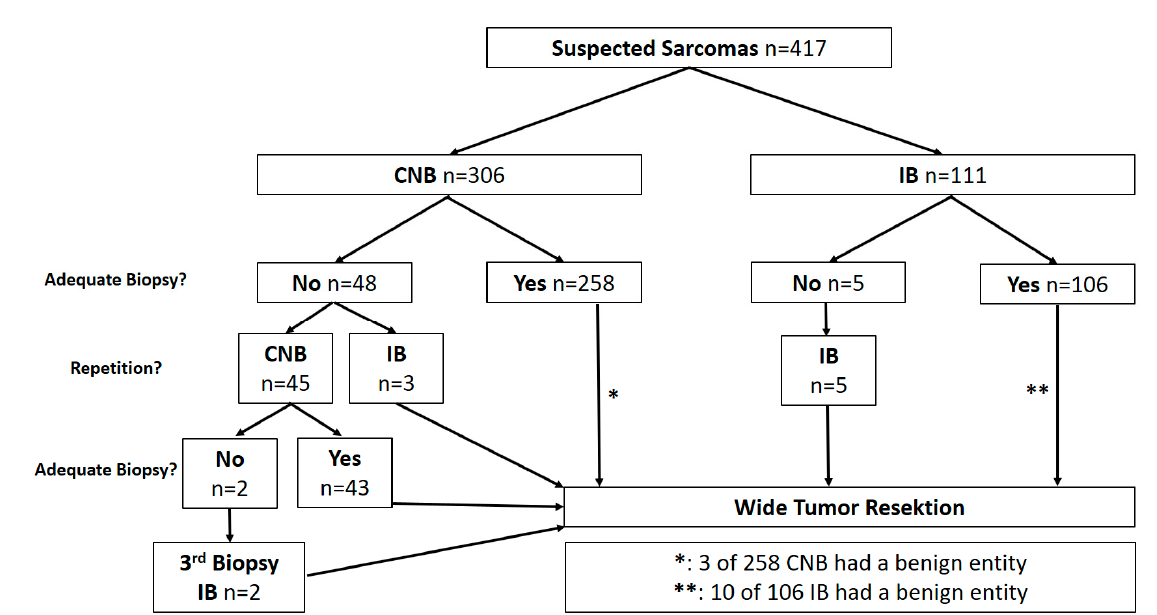
Figure 2. Characteristics of biopsies (CNB: Core needle biopsy, IB: Incisional biopsy).